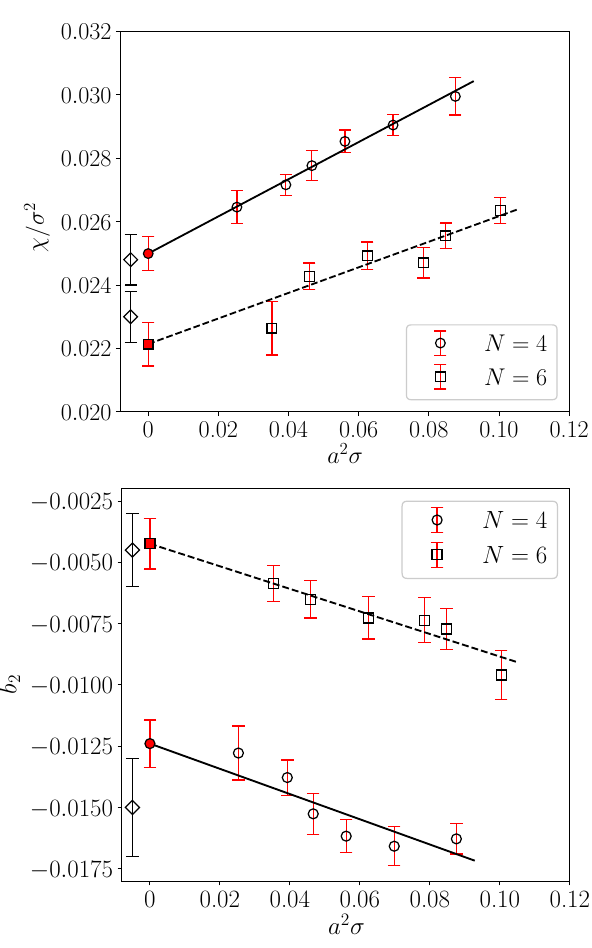
Figure 6 . Continuum extrapolations of χ/σ 2 (above) and b 2 (below) for N = 4 and 6 (solid and dashed line respectively) obtained fitting linear corrections in a 2 σ to the continuum limit. The reported best fits yield, respectively for N = 4 and 6, χ 2 / dof = 0 . 8 / 4 and 3 . 7 / 4 for χ/σ 2 and χ 2 / dof = 4 . 9 / 4 and 1 . 2 / 4 for b 2 . The diamond points represent the determinations reported in ref. [13] for N = 4 and